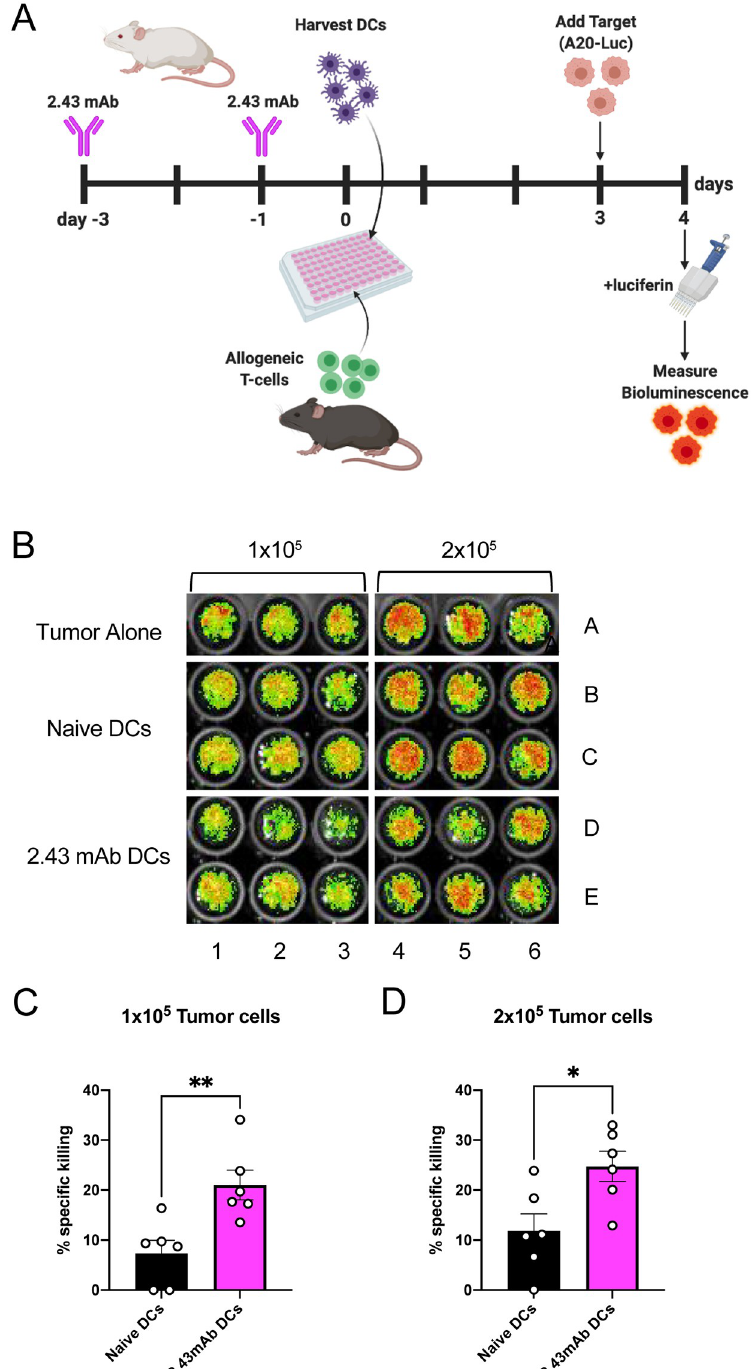
Fig 5. Depletion of CD8 α + cDC1s results in improved tumor-killing. BALB/c mice were dosed with 200 μ g of 2.43 mAb antibody intraperitoneally on day -3 and day -1. On day 0, splenic DCs were isolated and plated with allogeneic T-cells. On day 3 of co-culture A20-Luc tumor cells were added to wells at the indicated concentrations. On day 4, luciferin was added to wells and plates were imaged. BLI was measured for each independent well and averaged among technical replicates. BLI values were used to quantify specific killing as a percent of tumor alone control. Data is pooled from two independent experiments. (n = 6 per group) (A) Schematic depicting the experimental timeline. (B) Representative bioluminescence image depicting plate layout and showing BLI intensity on a scale from low (green) to high (red) indicative tumor burden. (C-D) Mean percent specific killing is shown with SEM for A20-Luc